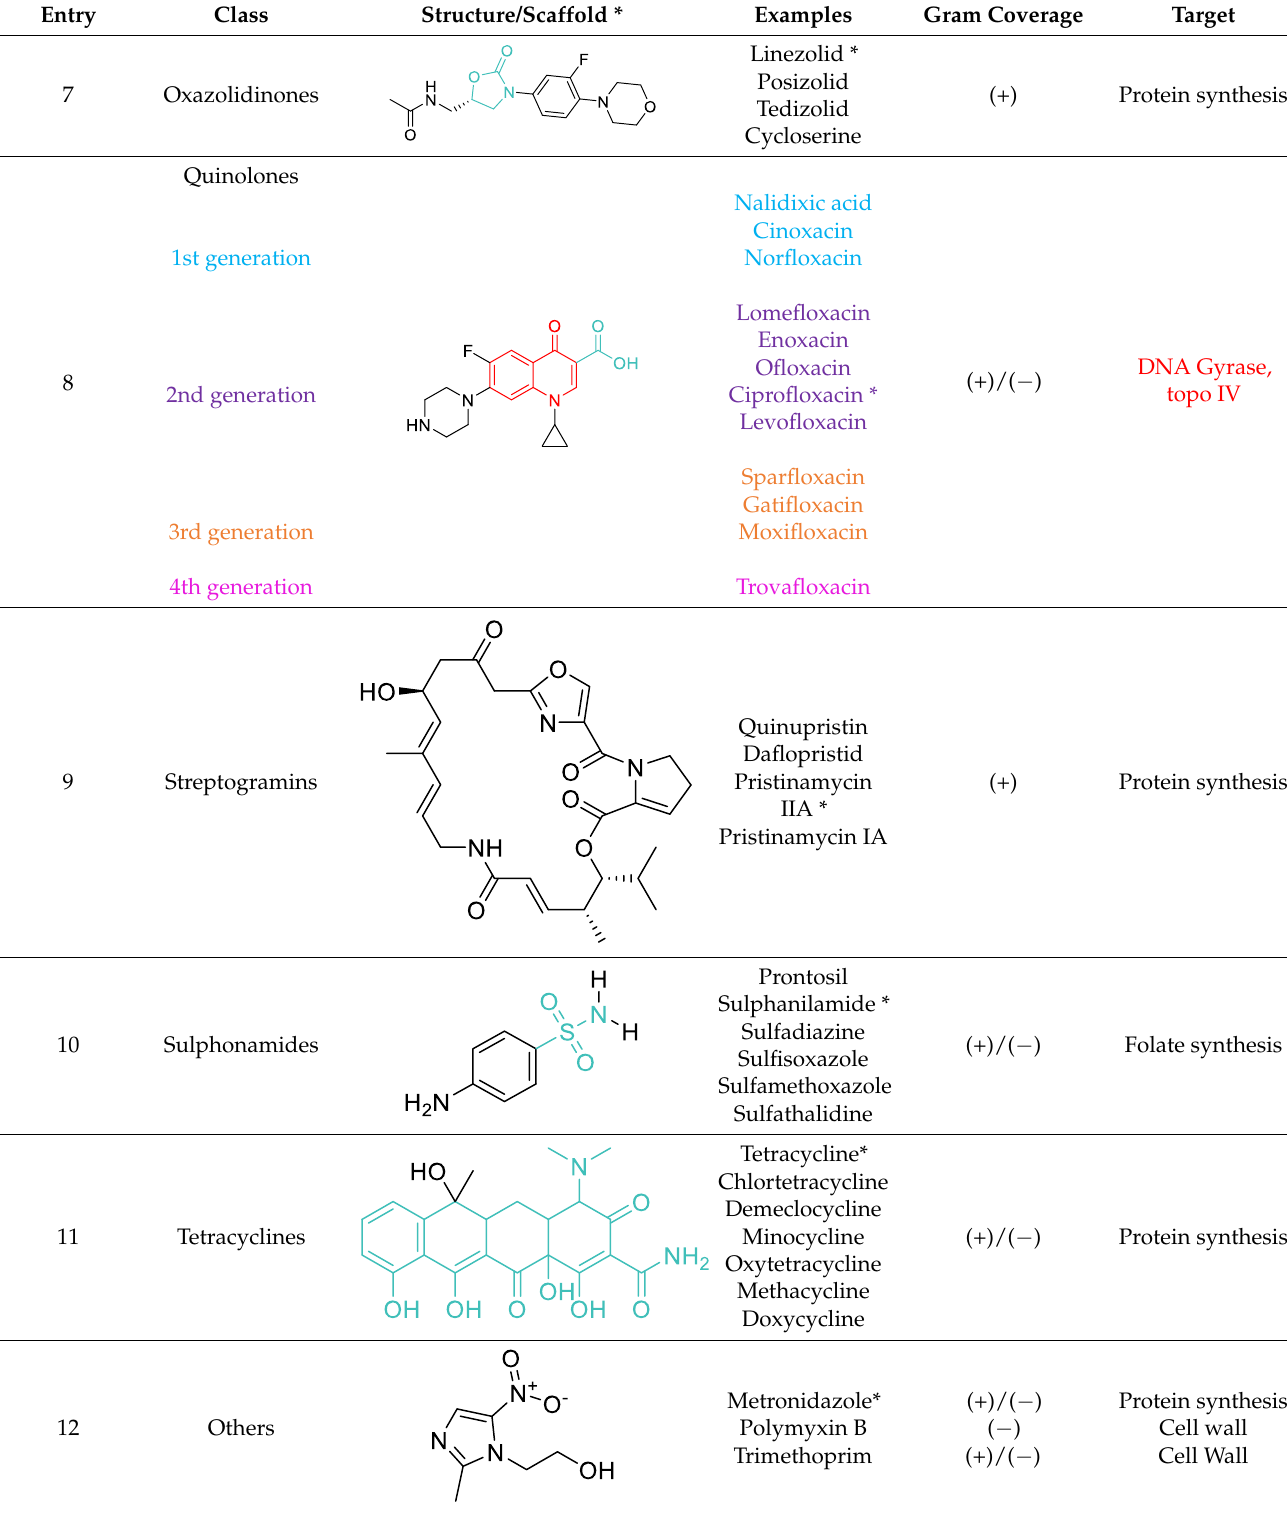
* indicates the molecule shown, with the core structures/scaffolds of each category colored in light green, except for quinolones, which are colored red.